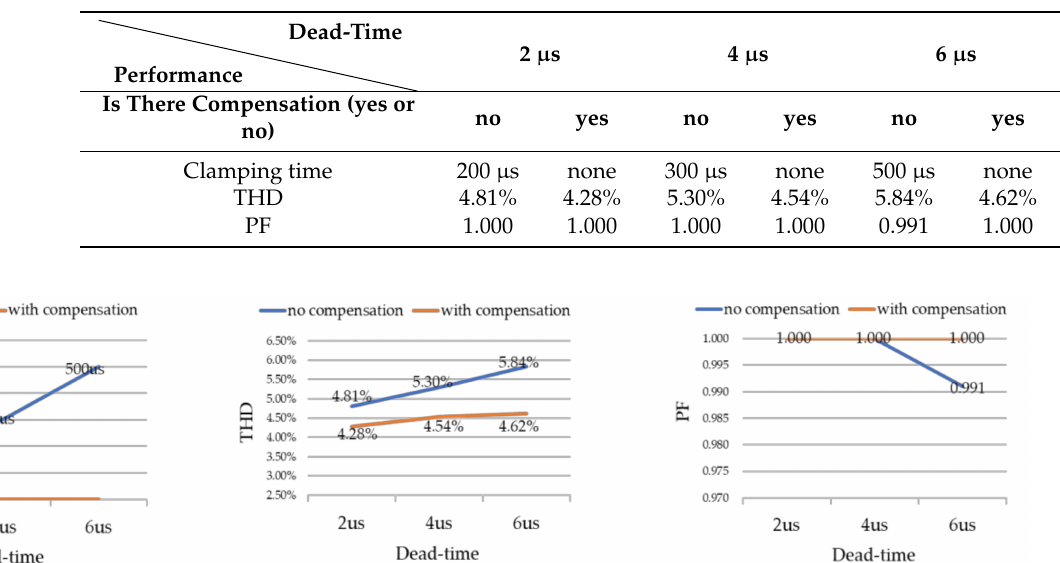
Table 7. Results of the dead-time compensation experiment.